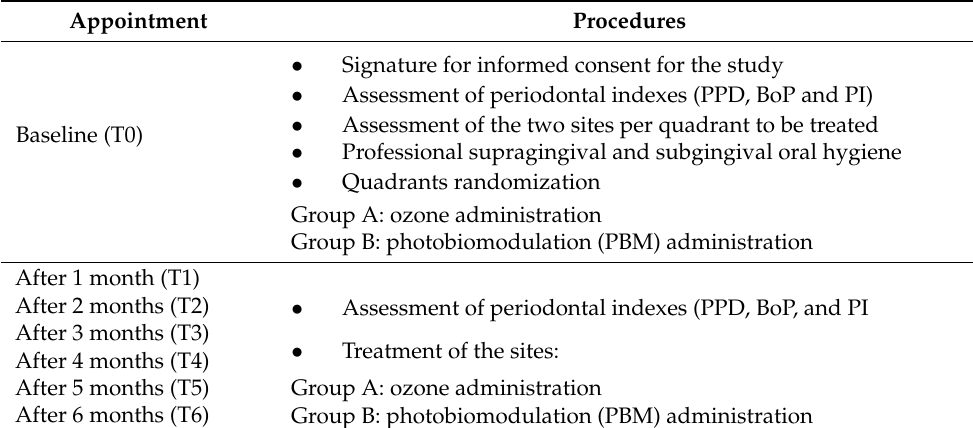
Table 2. Protocol adopted for the